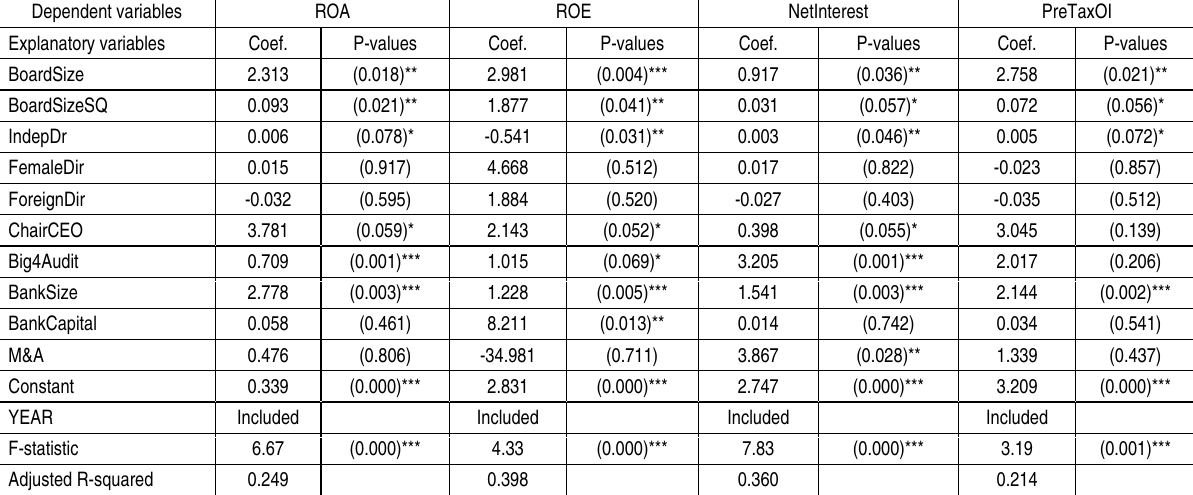
Table 2. Pooled OLS empirical findings with the inclusion of